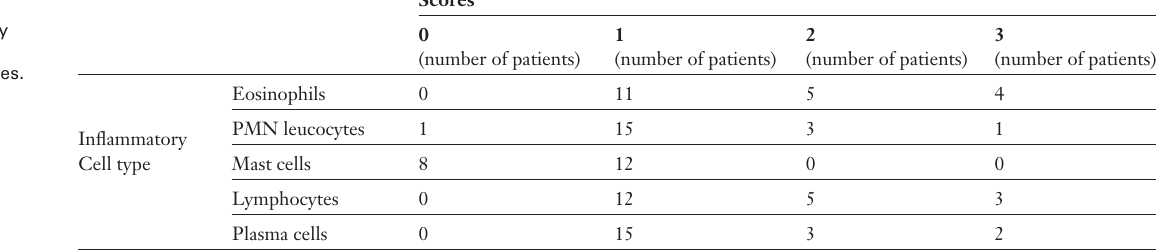
Table 2 MMP-9/TiMP-1 ratio in polyp tissues and control group.